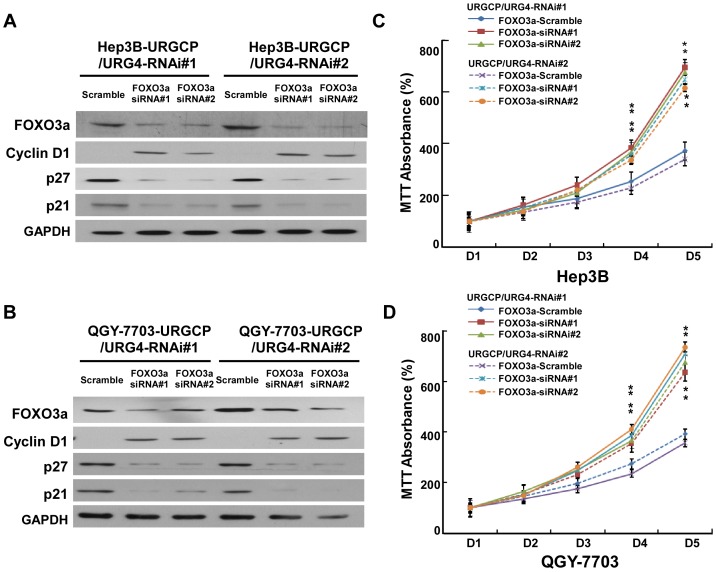
Silencing URGCP/URG4 expression impaired cell proliferation through FOXO3a.Western blotting analysis of p21Cip1, p27Kip1, cyclin D1 and FOXO3a proteins in indicated Hep3B (A) and QGY-7703 (B) cell lines. Silencing FOXO3a increased the proliferation of URGCP/URG4 shRNA(s)-transduced cells as determined by MTT assay in Hep3B (C) and QGY-7703 (D) cells. GAPDH was used as a loading control for all Western blots. Error bars represent SD from three independent experiments. *P<0.05.